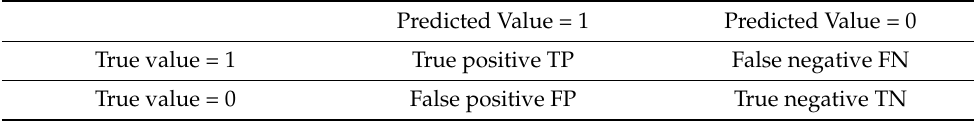
Table 1. Confusion matrix.